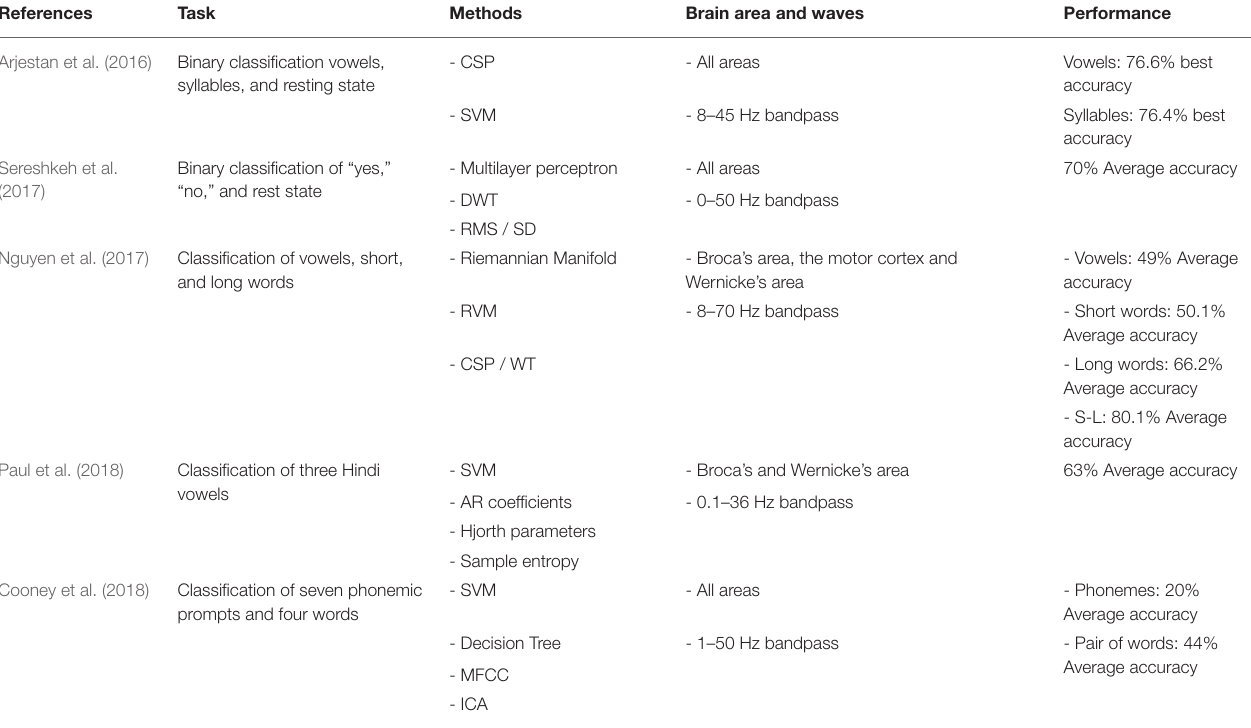
TABLE 3 | Imagined speech classification methods summary